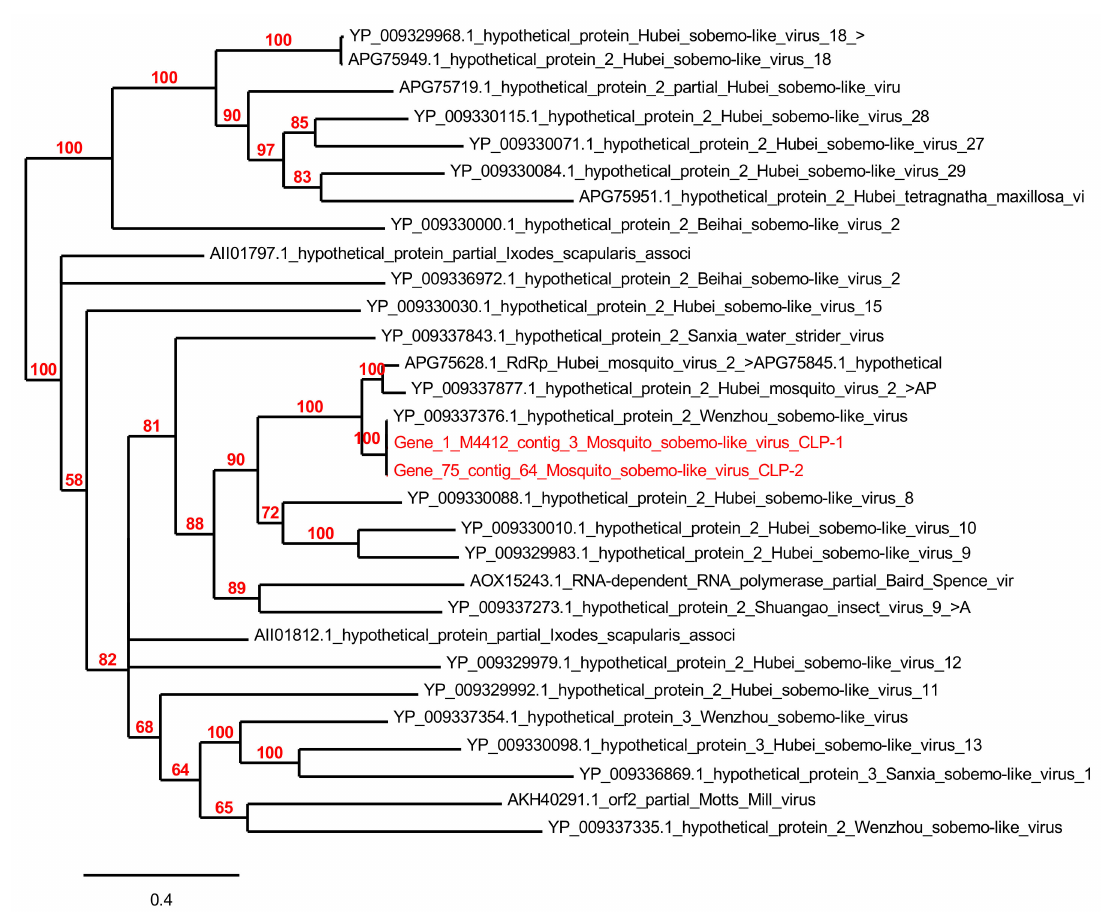
Figure 7. Phylogenetic analysis of mosquito Somebo -like virus CLP-1 and 2 compared to other Sobemo